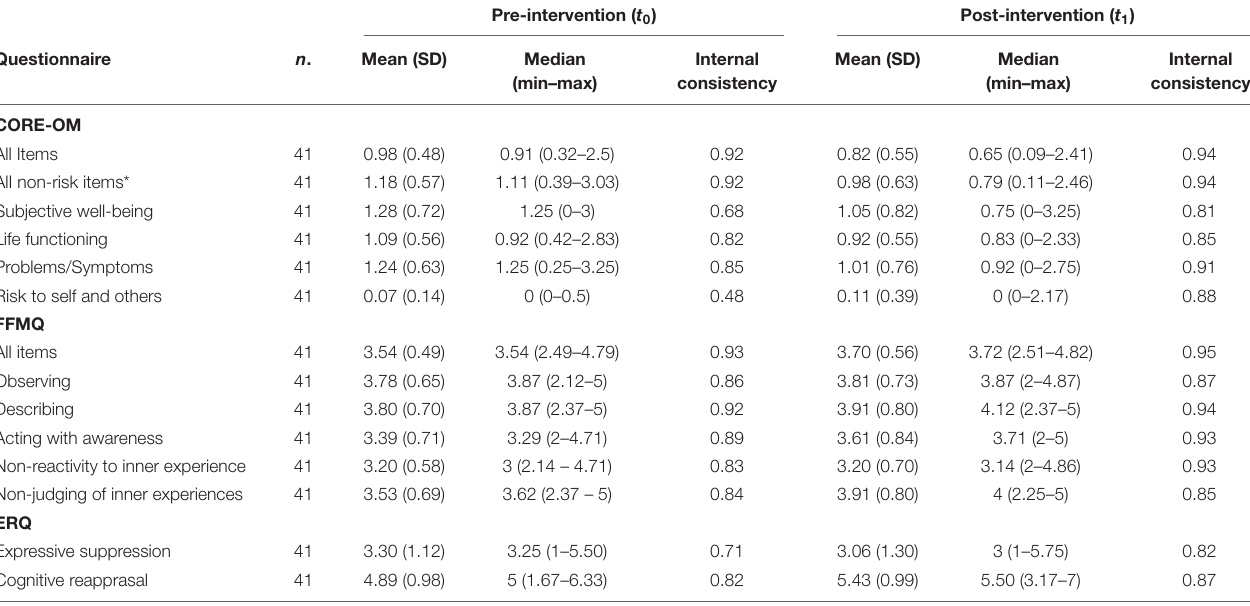
TABLE 2 | Summary of the pre/post intervention outcome measurement: mean (SD), median (min, max), and internal consistency. Pre-intervention ( t 0 ) Post-intervention ( t 1 )